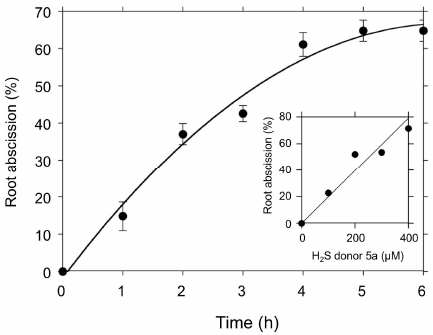
Figure 3. Effects of H 2 S donors on root abscission. Root abscission is represented as % of the detached roots incubated for 24 h with a 10 mM Hepes‐KOH (pH 7.0) buffer containing the H 2 S donor (100 µM). The values are means ± SE ( n = 3). Significant differences are indicated as * or ** ( p < 0.001).